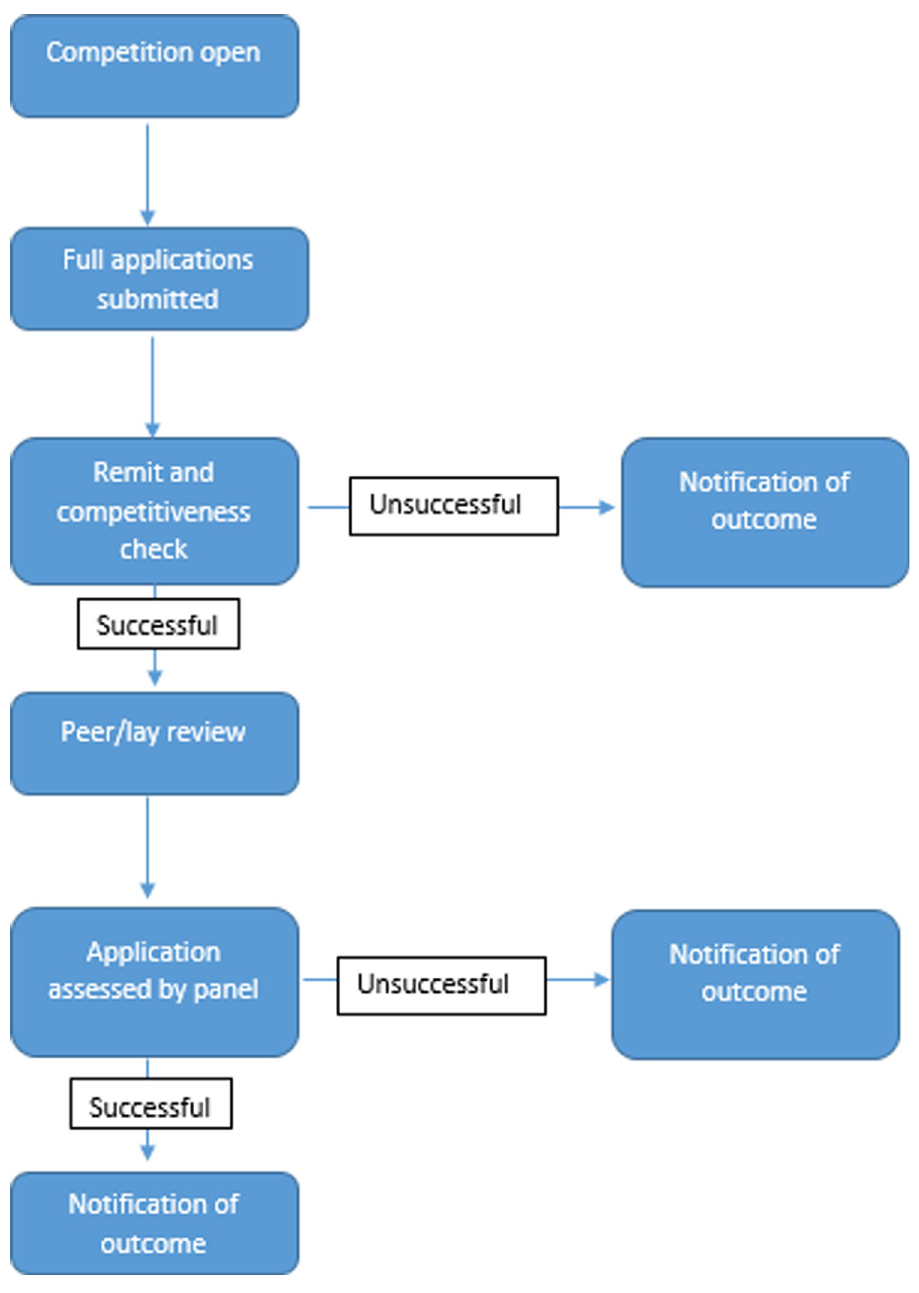
Fig 1. Flowchart of one-stage assessment